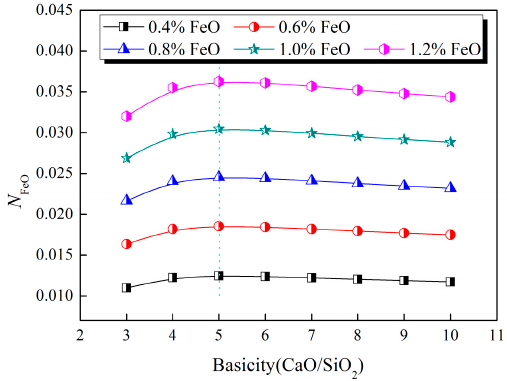
Figure 2. Effect of FeO content on the optimal alkalinity.